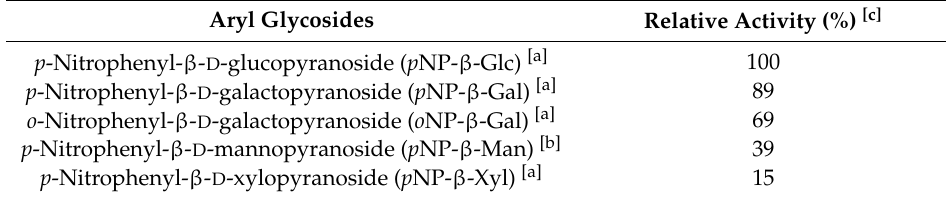
Table 1. Substrate specificity of recombinant β -glycosidase from Pyrococcus woesei strain DSM 3773 for the hydrolysis of aryl glycosides at 85 ˝ C in 25 mM citrate-phosphate buffer, pH 5.5. Aryl Glycosides Relative Activity (%)